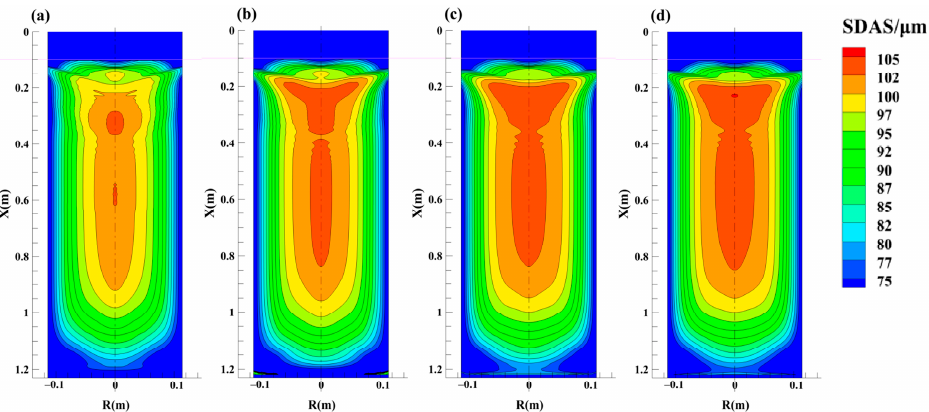
Figure A4. Distribution of PDAS with varying filling ratio: ( a ) 0.16, ( b ) 0.23, ( c ) 0.33 and ( d ) 0.43.